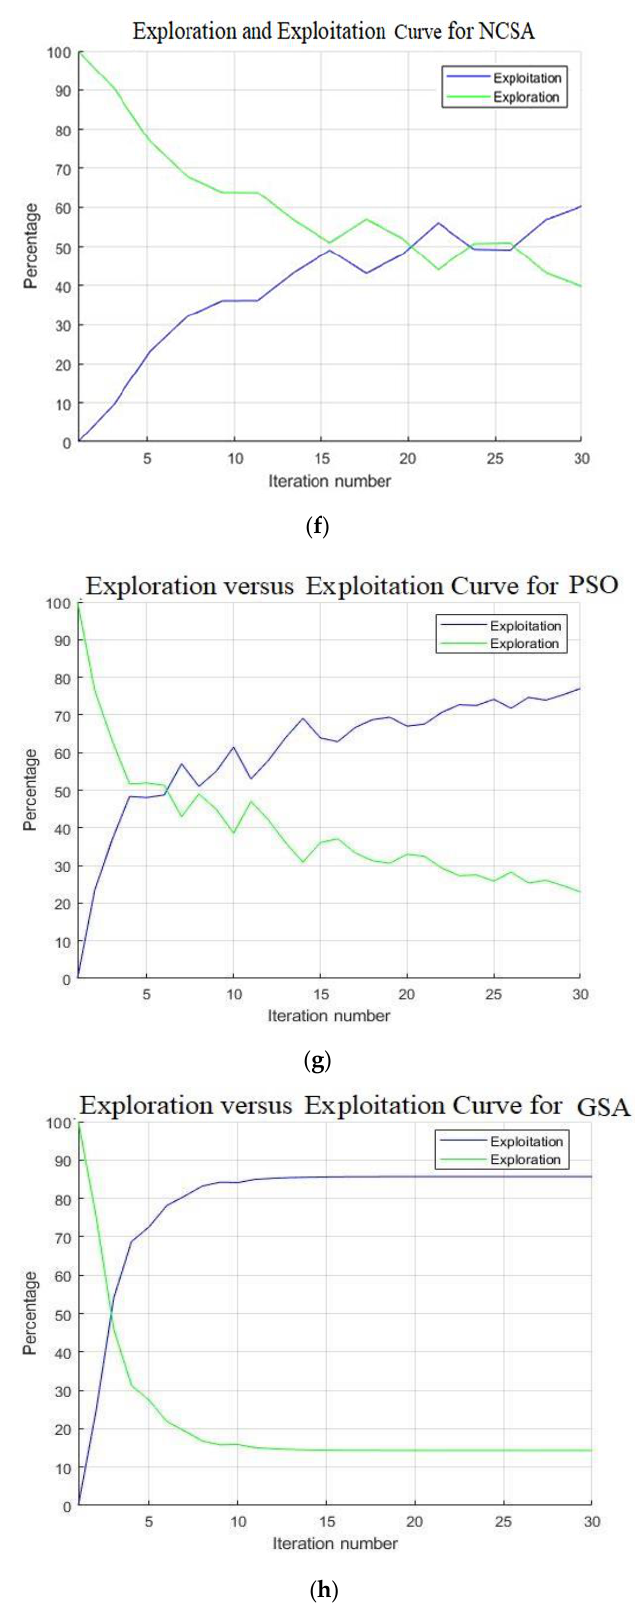
Figure 10. Exploration and exploitation curve for PSO, GSA, CSA, and NCSA ( a – h ), ( a ) CSA for case study 1, ( b ) NCSA for case study 1, ( c ) PSO for case study 1, ( d ) GSA for case study 1, ( e ) CSA for case study 2, ( f ) NCSA for case study 2, ( g ) PSO for case study 2 and ( h ) GSA for case study